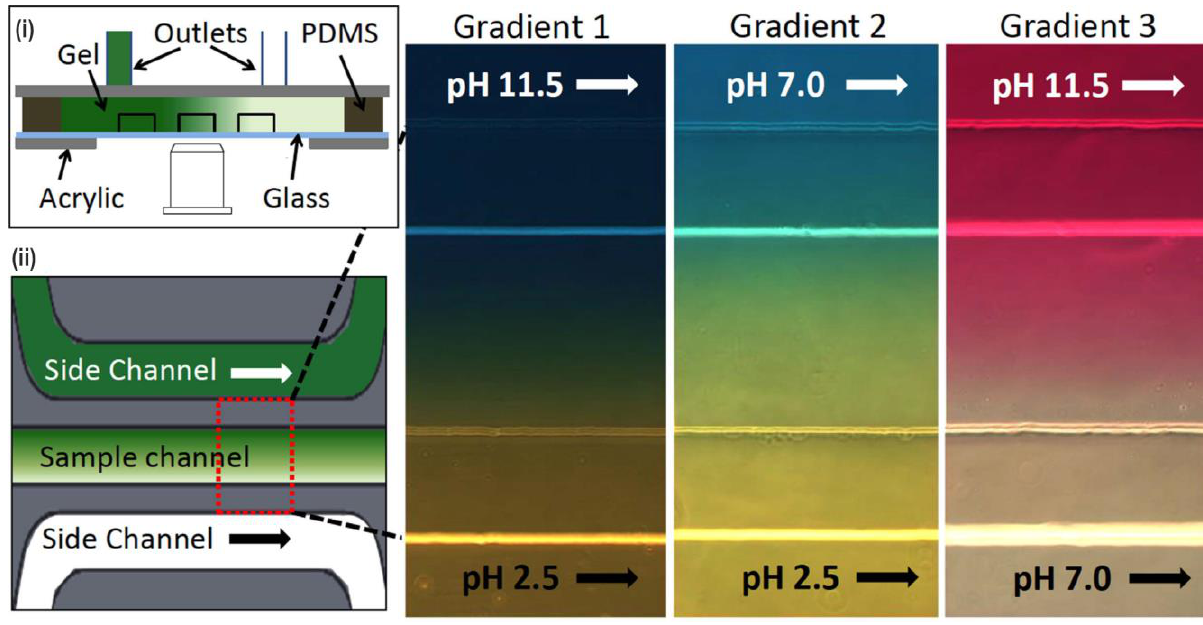
FIGURE. 6: Microfluidic device for bacterial pH taxis. (i) Schematic diagram of microfluidic device filled by hydrogel in between three chan- nels and PDMS wall. Acrylic plates clamped the channel attached in the glass slide with the support of PDMS wall. (ii) Schematic diagram of a single sample channel between two side channels. Three different pH gradients (red-dotted rectangular box) were generated by running HCl or NaOH into side channels (green: higher pH, white: lower pH). Reproduced from